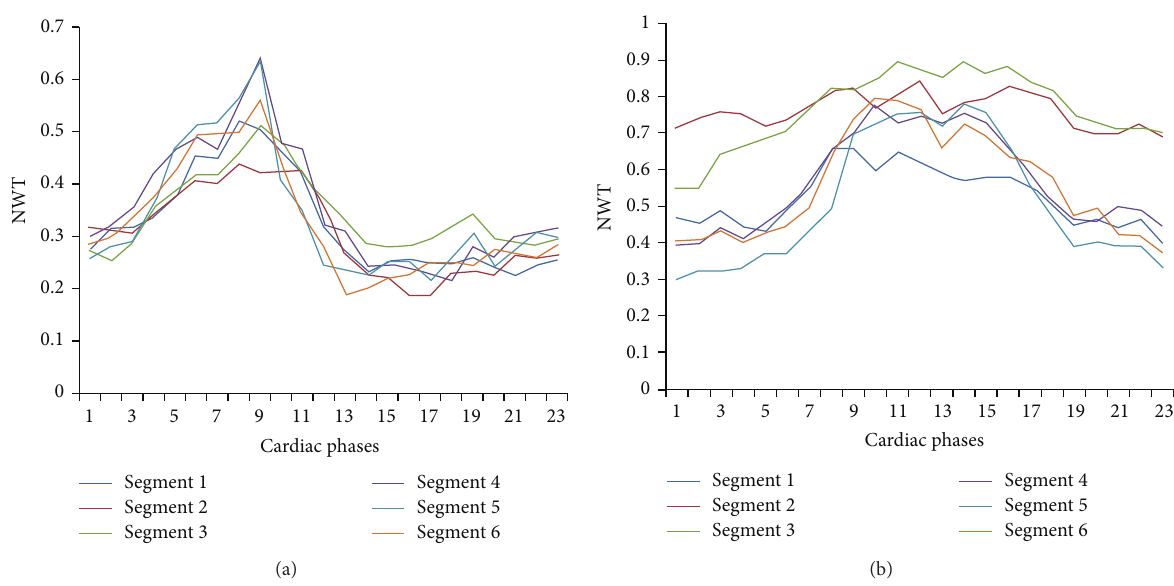
Figure 2: Normalized wall thickness (NWT) throughout the cardiac cycle for all segments in a midventricular slice from (a) normal volunteer and (b) patient with hypertrophic cardiomyopathy